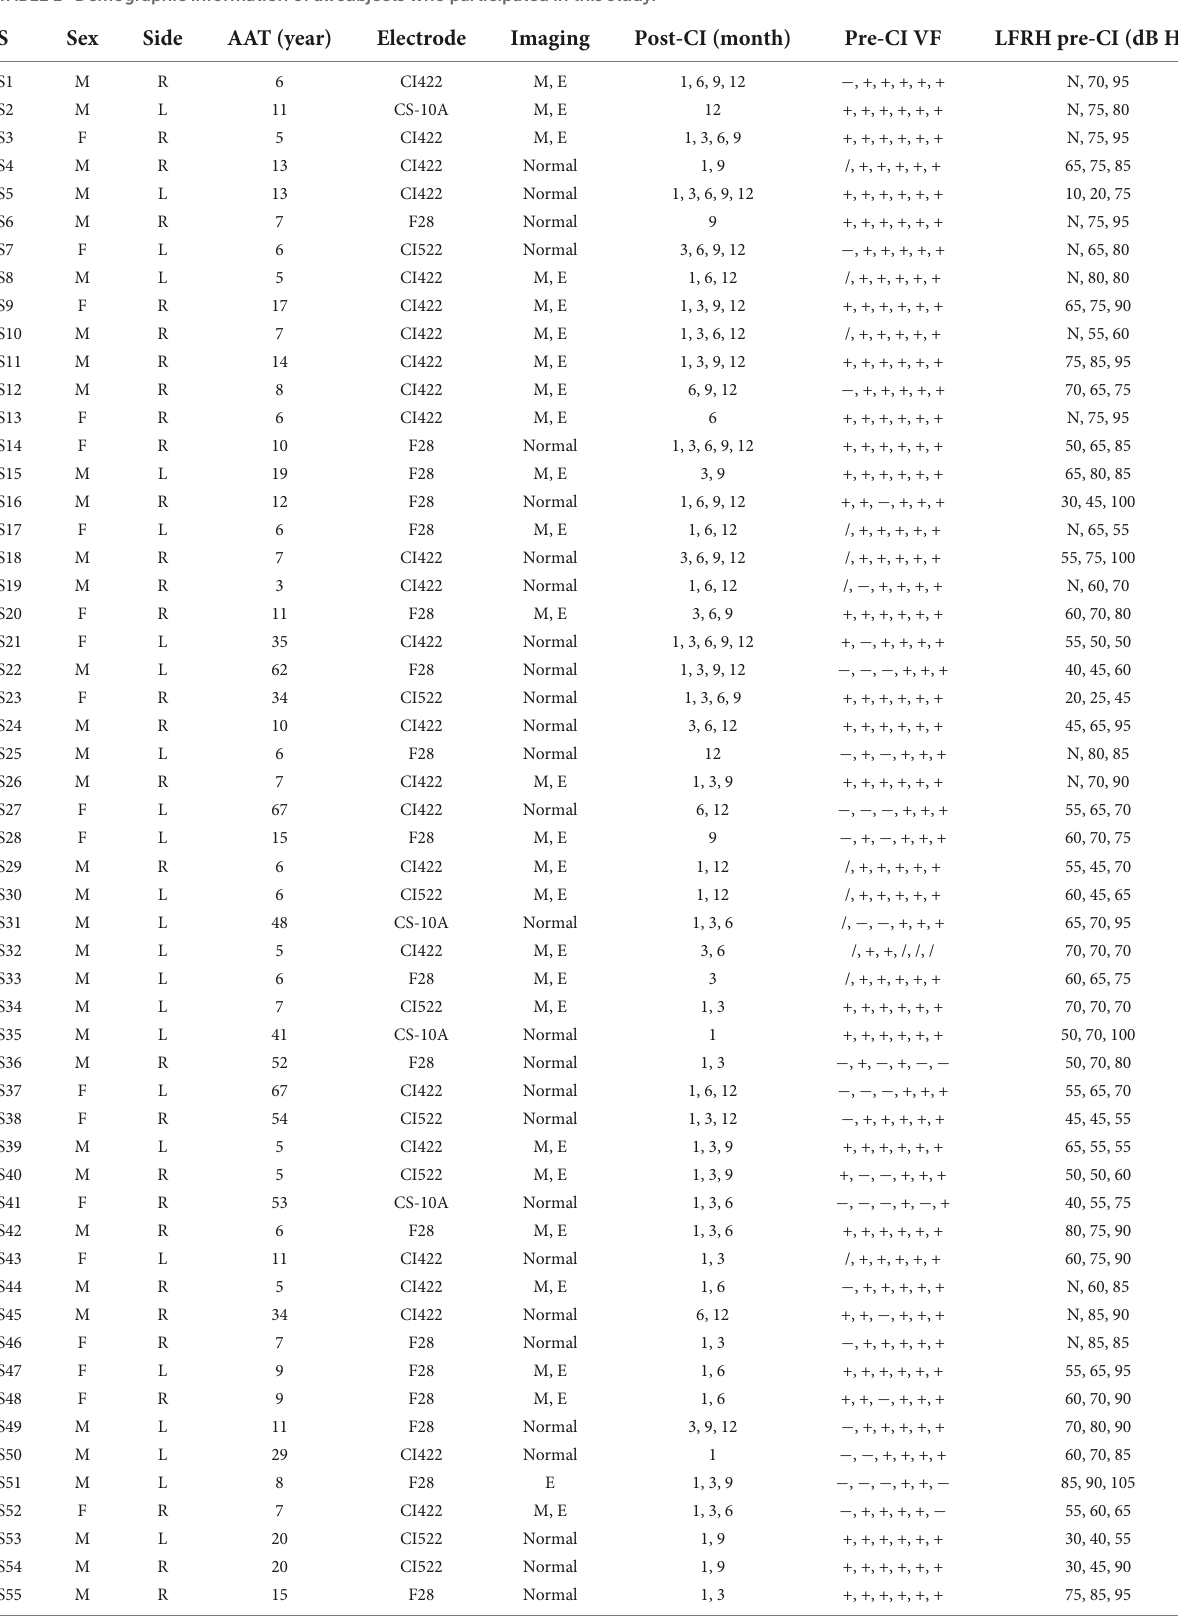
TABLE 1 Demographic information of all subjects who participated in this